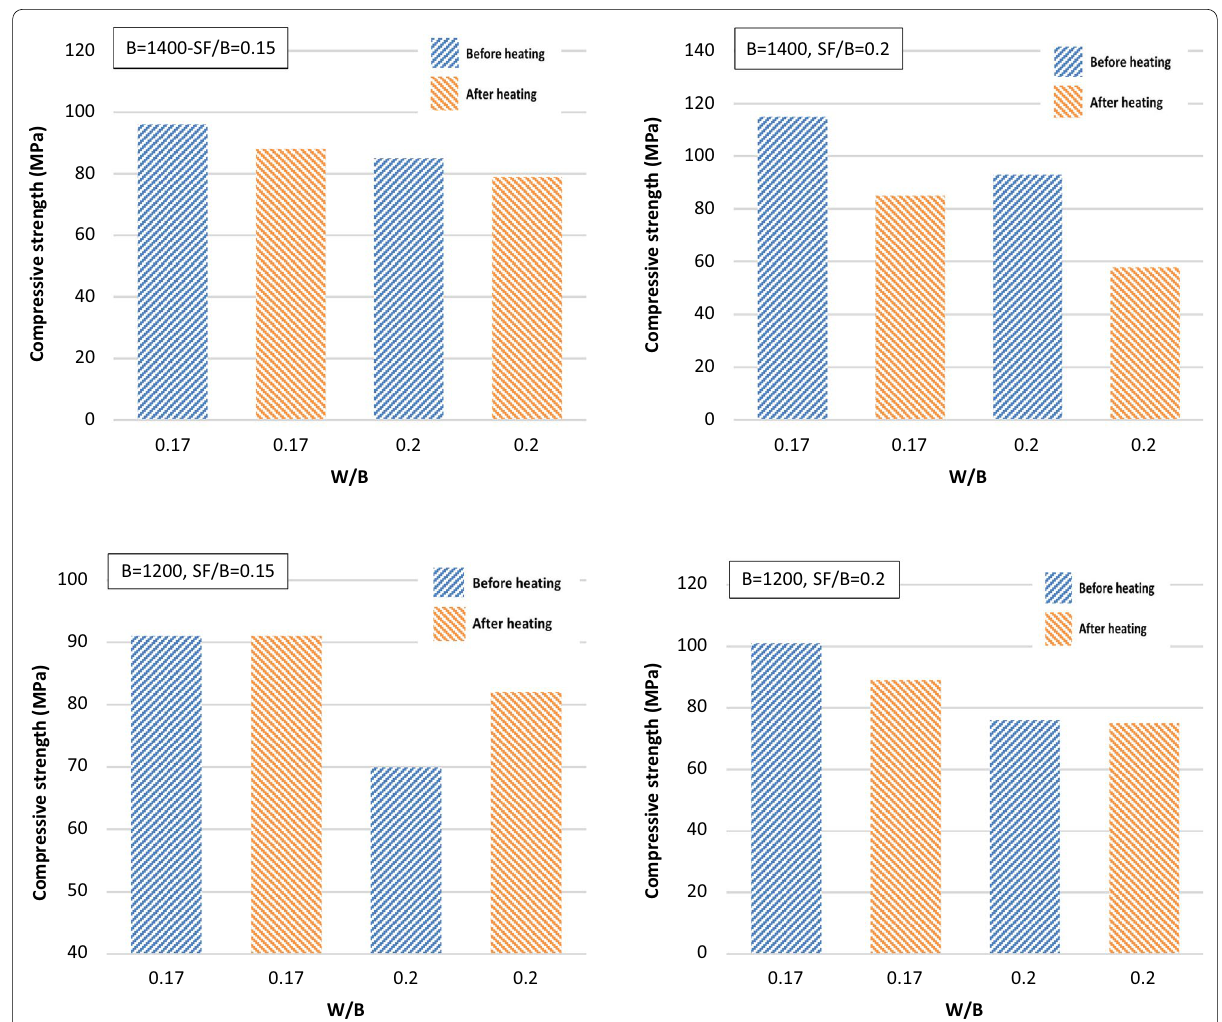
Fig. 13 Variations of compressive strength of concrete mixes against W/B before and after